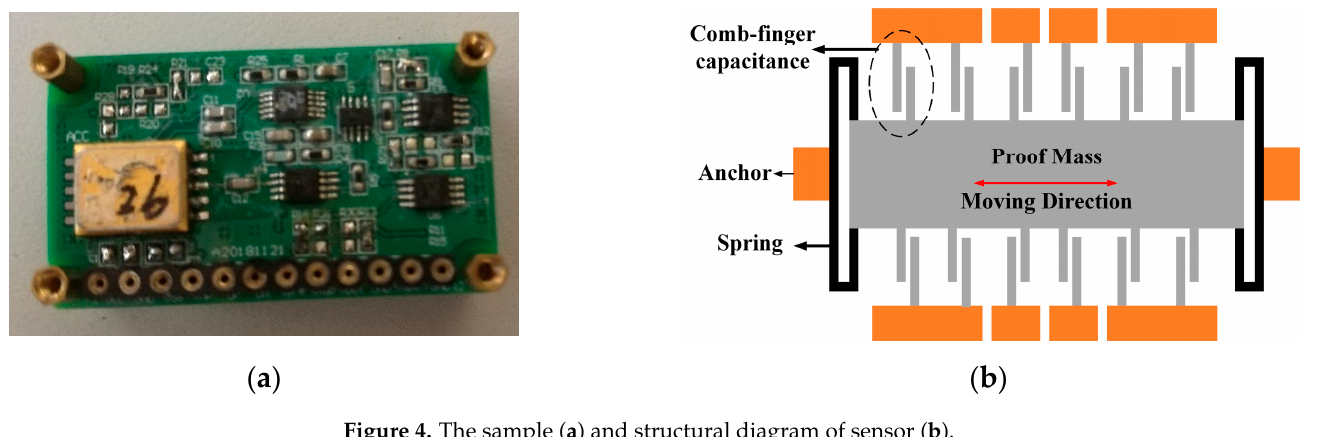
Figure 4. The sample ( a ) and structural diagram of sensor ( b ).